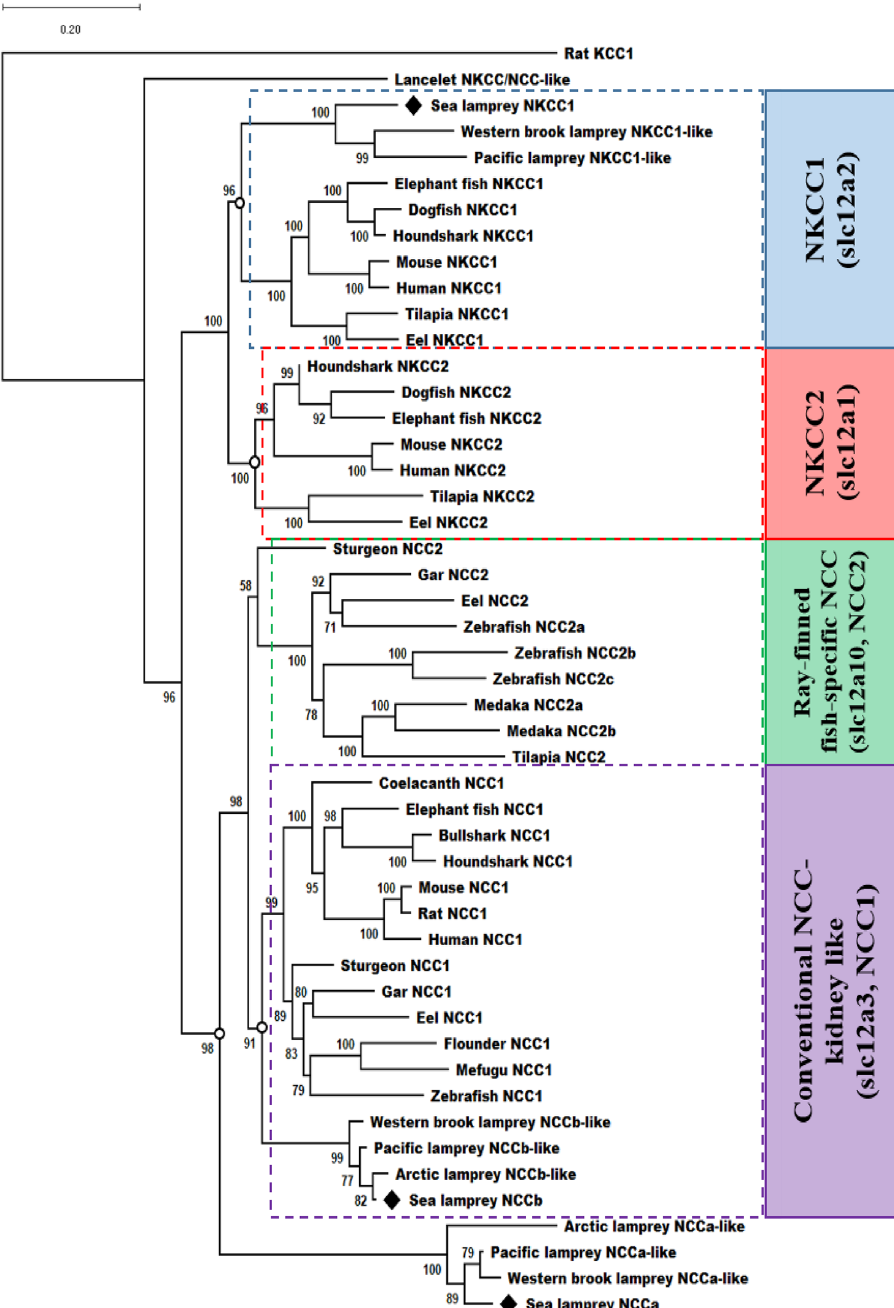
Figure 1. Molecular phylogenetic tree of vertebrate NKCC/NCC family. Rat KCC1 was used as an outgroup to root the